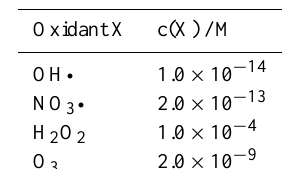
Table 4. Oxidant concentrations for an urban cloud droplet cal- culated from CAPRAM3.0i at 20–44h reaction time (Tilgner and Herrmann, 2010).